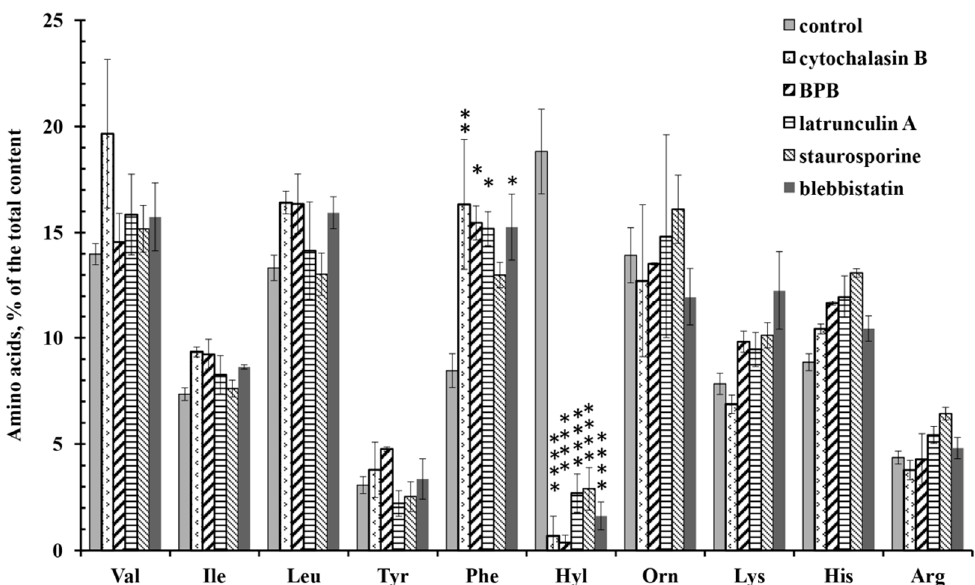
Figure 7. Free amino acid composition of neutrophil secretion during adhesion to fibronectin in the presence of drugs affecting the actin cytoskeleton. Human neutrophils were incubated over fibronectin-coated substrata for 20 min or in the presence of: 10 µg/mL cytochalasin D; 25 µM 4-bromophenacyl bromide; 1 µM latrunculin A; 0.2 µM staurosporine (A); 10 µM blebbistatin. Amino acid profiles were obtained by summing the results of three independent experiments. The amount of amino acid is represented as a percentage of the total content of the detected free amino acids (mean ± SEM). *—significant differences when compared to the value for the same amino acid in the control cells (*— p < 0.01; **— p < 0.001; ****— p < 0.0001). (Val—valine; Ile—isoleucine; Leu—leucine; Tyr—tyrosine; Phe—phenylalanine; Hyl—hydroxyly-